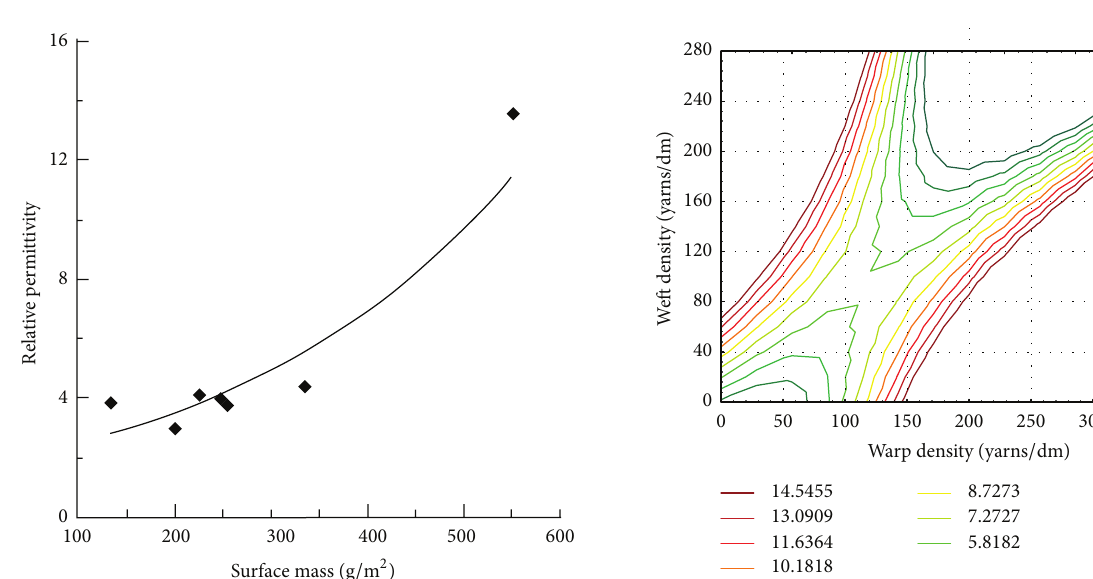
Figure 9: Variation of relative permittivity for weaves from natural cellulosic fibers depending on mass surface.